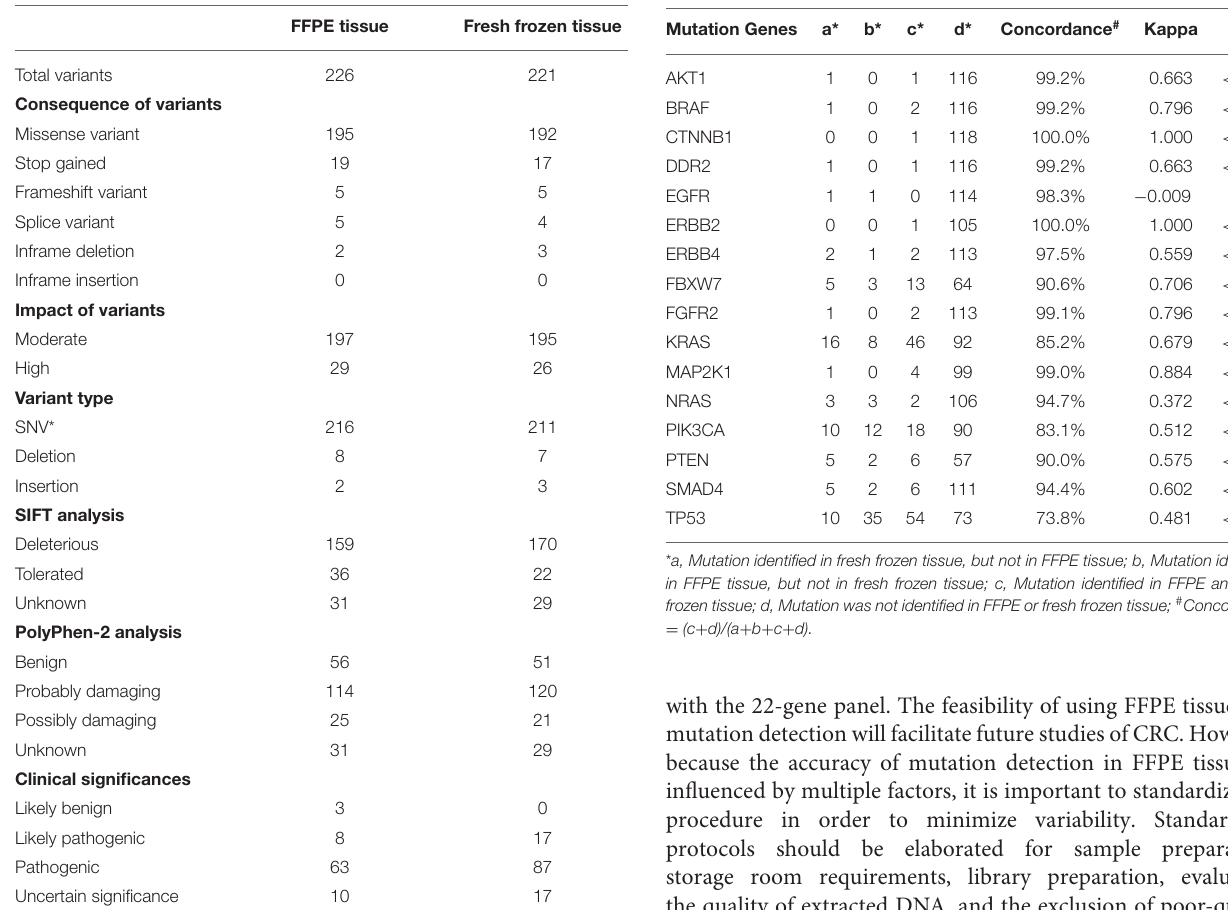
FFPE vs. Fresh Frozen Tissue